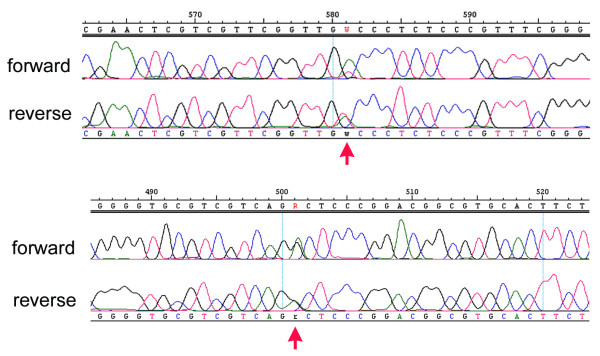
Two examples for ambiguous sequence positions in the forward and reverse sequencing direction of the same fragment (indicated by a red arrow). We interpret these ambiguities as polymorphic positions among the rDNA repeat units within an animal. Given that these ambiguities are very rare (see text), one can conclude that homogenization is usually very efficient.